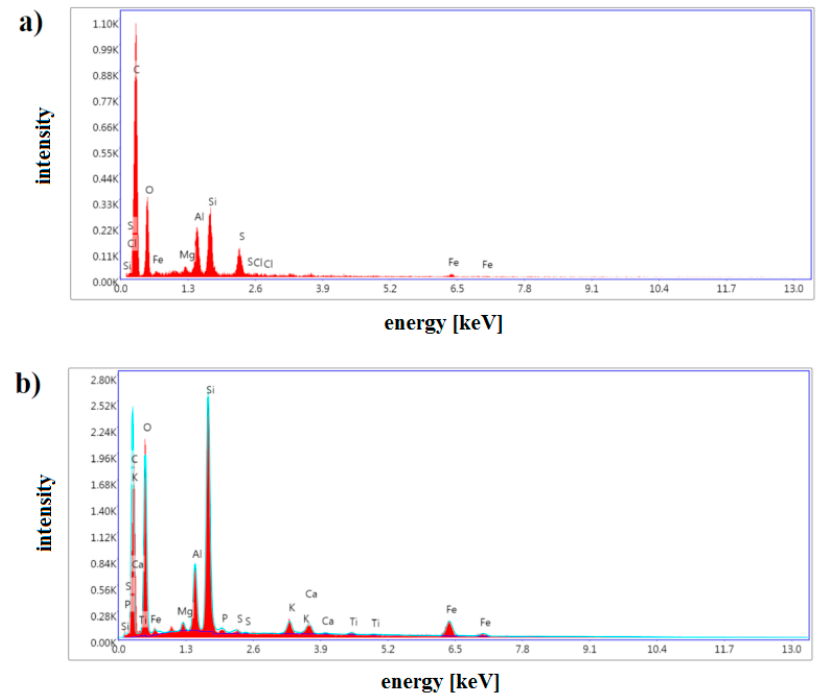
Figure 6. EDS graph for: ( a ) dust 1, ( b ) dust 2.